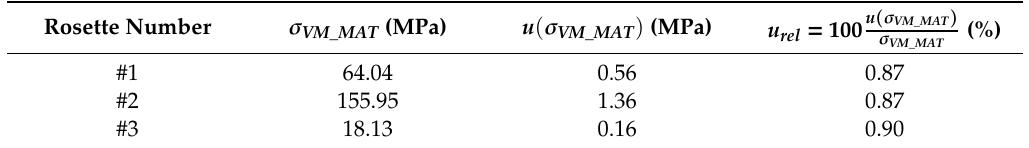
Table 9. Uncertainty quantification of the crank arm model due to the material properties and the applied load.